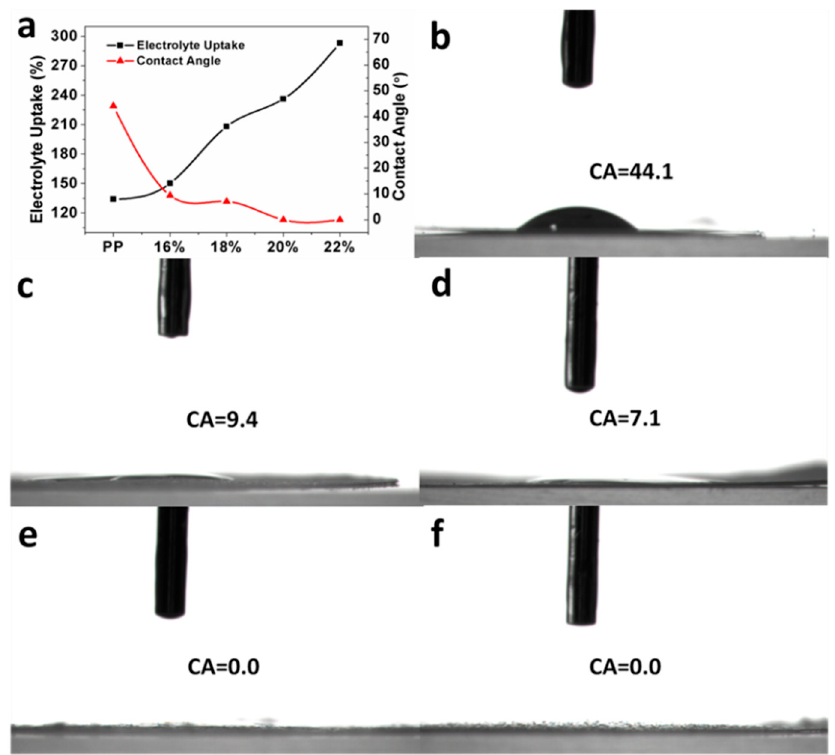
Figure 3. ( a ) The contact angle and electrolyte uptake of the PP separator and the composite separators; photography of the PP separator and the composite separators. Images showing the electrolyte droplet on ( b ) PP separator; ( c ) PET/PP-16%; ( d ) PET/PP-18%; ( e ) PET-PP-20%; and ( f ) PET/PP-22%.